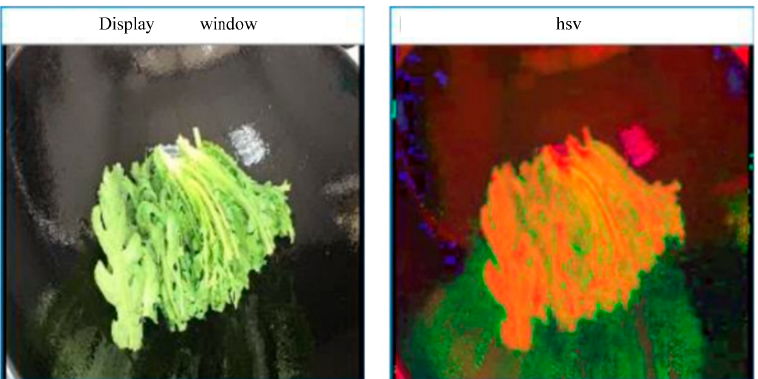
Figure 1. Convert RGB to HSV (( left ) is the original image, ( right ) is the false color operation image after HSV conversion).